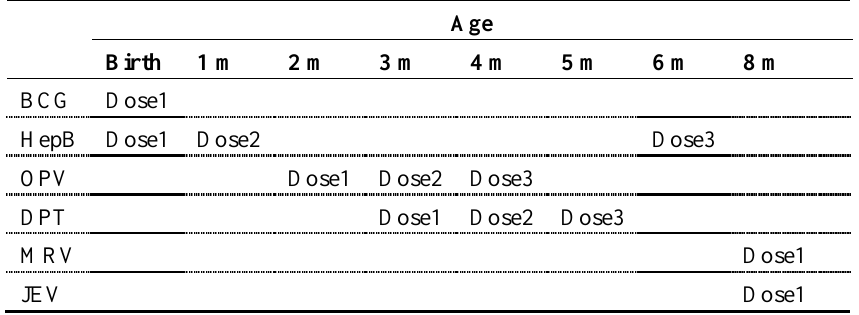
Table 1. Recommended childhood primary immunization schedule in